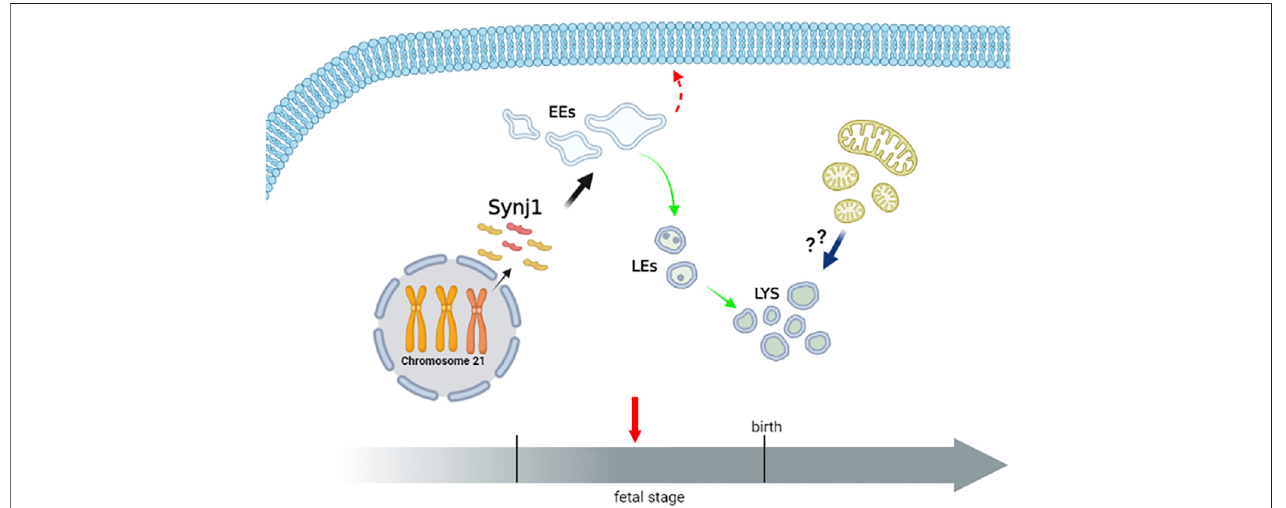
FIGURE 11 | Perturbation of endosomal traf fi cking is altered early in Down syndrome. The scheme recapitulates the alterations of the endolysosomal pathway observed in DS fetal fi broblasts. The homeostasis of early, but not late, endosomal compartments is altered in DS cells. Moreover, the recycling pathway to the cell ’ s surfaceisperturbed,whilethetraf fi ckingtowardthelysosomesisunaffected.LysosomalcompartmentisslightlyalteredinDScells.Whetherlysosomalalterationsre fl ect a compensatory mechanism consequent to the altered dynamics of EEs, an increased autophagy/mitophagy pathway or both remain important intriguing open questions. Hence, a dysfunctional endolysosomal pathway might contribute to the pathogenesis of DS, and Synj1, whose expression is already increased in the fetal stage, may play a potentially critical role (Created with